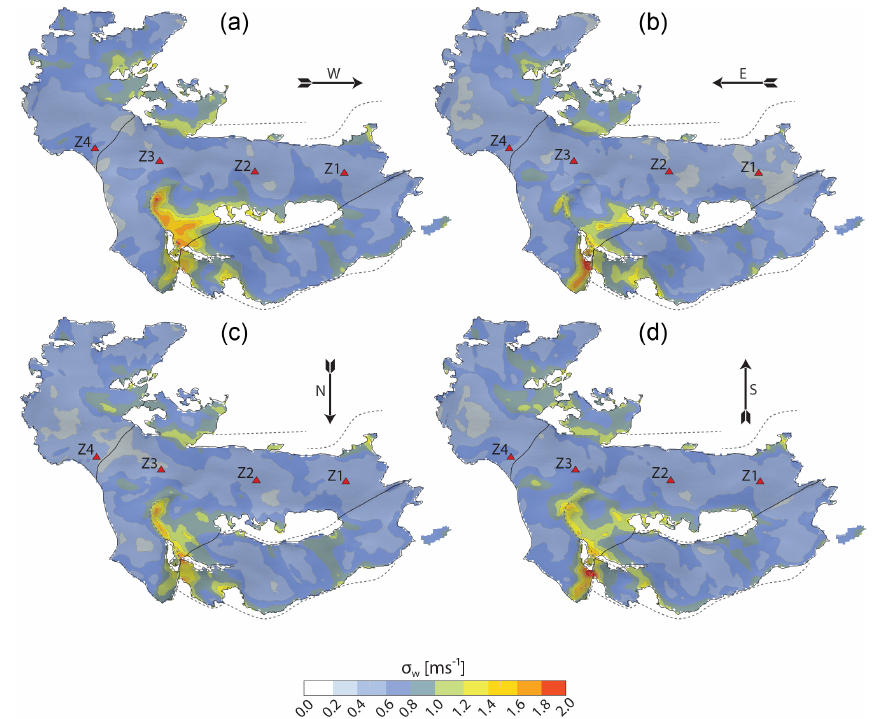
Figure 6. Standard deviation of the vertical velocity fluctuation at 2m above ground for each of the four case experiments.